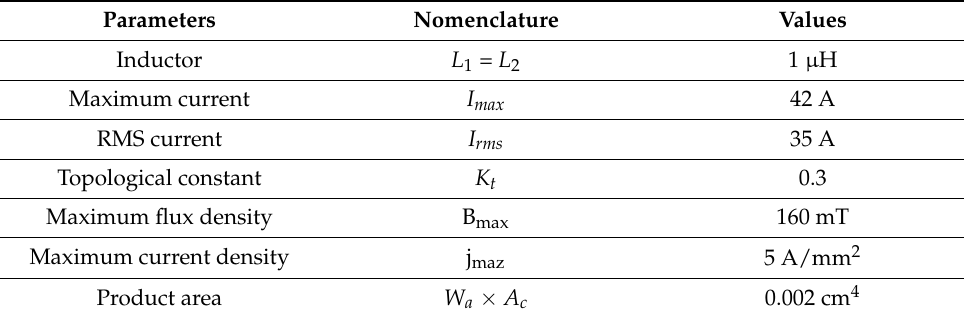
Table 5. Parameters for designing the split inductors.